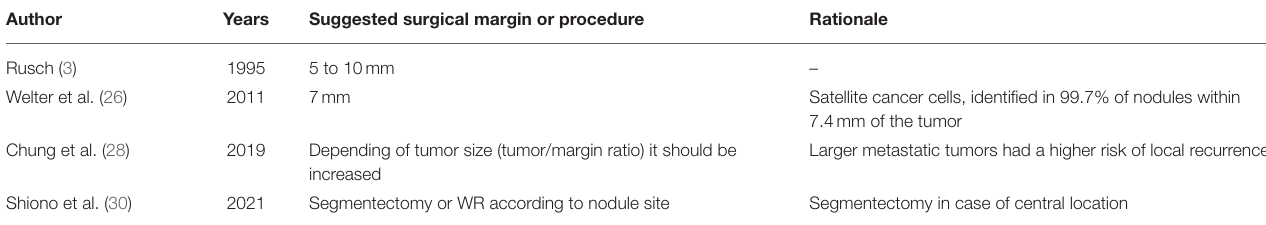
TABLE 1 | Surgical margin and suggested procedure.